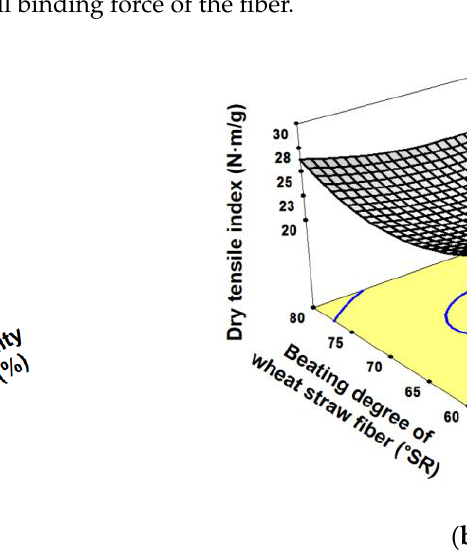
Figure 1. Response surface plot of factors affecting dry tensile index: ( a ) Influence of beating degree of unbleached sulfate conifer pulp fiber and wheat straw fiber quality percentage content on dry tensile index; ( b ) Influence of beating degree of wheat straw fiber and wheat straw fiber quality percentage content on dry tensile index.